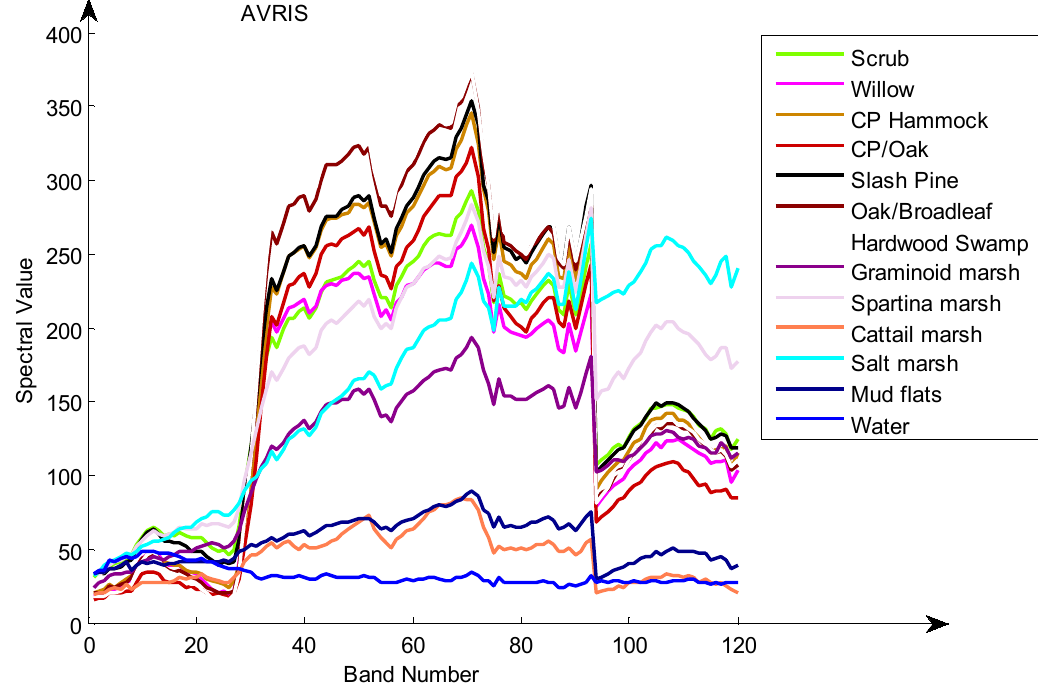
Fig.3 The spectral curves of object categories feature of AVIRIS data